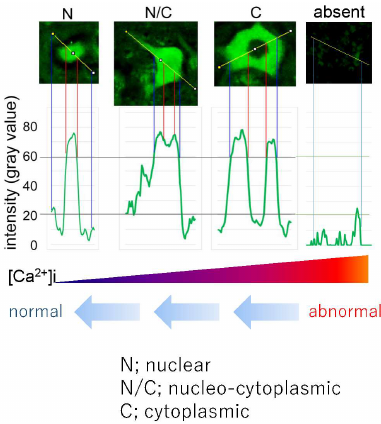
Figure 6. Subcellular localization of transactive response DNA-binding protein (TDP-43) and Ca 2+ influx in adenosine deaminase acting on RNA 2 (ADAR2)-deficient motor neurons. Representative anterior horn cells (AHCs) with different TDP-43 subcellular localization patterns in the conditional ADAR2 knockout mice (AR2): predominantly nuclear (N), nucleo-cytoplasmic (N/C), cytoplasmic (C) or lack of immunoreactivity. The vertical axis indicates the intensity (gray value), which was evaluated with ImageJ software. The threshold for TDP-43 positivity was set at a level three-fold higher (60 gray) than the background intensity (20 gray). This figure is modified from a previously published figure [48].